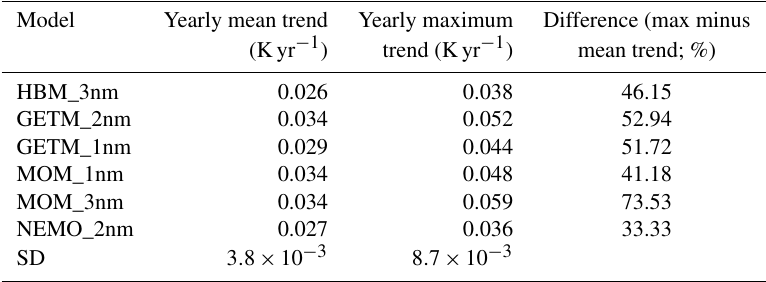
Table 2. Comparison of yearly mean and maximum temperature trends averaged over the whole Baltic Sea. Note that SD is for standard